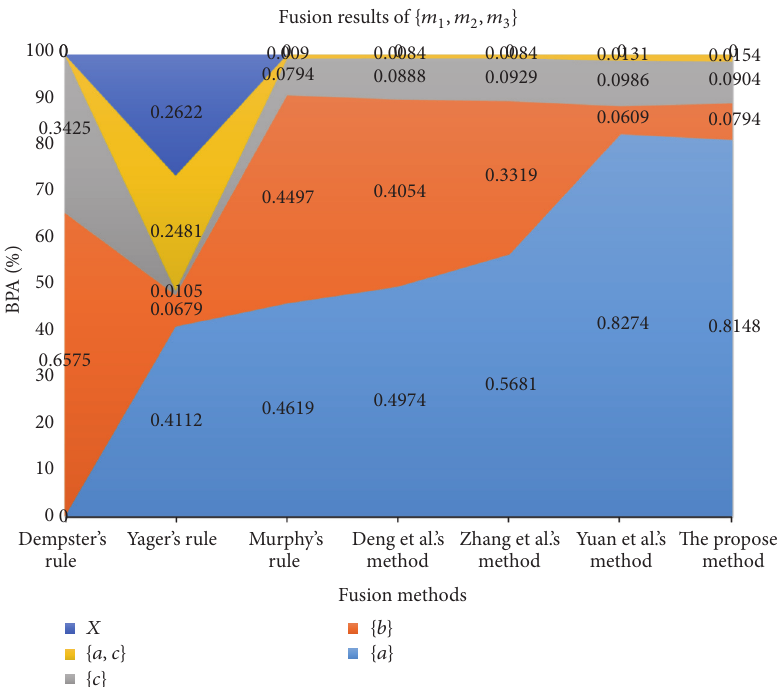
Figure 4: Fusion results of three